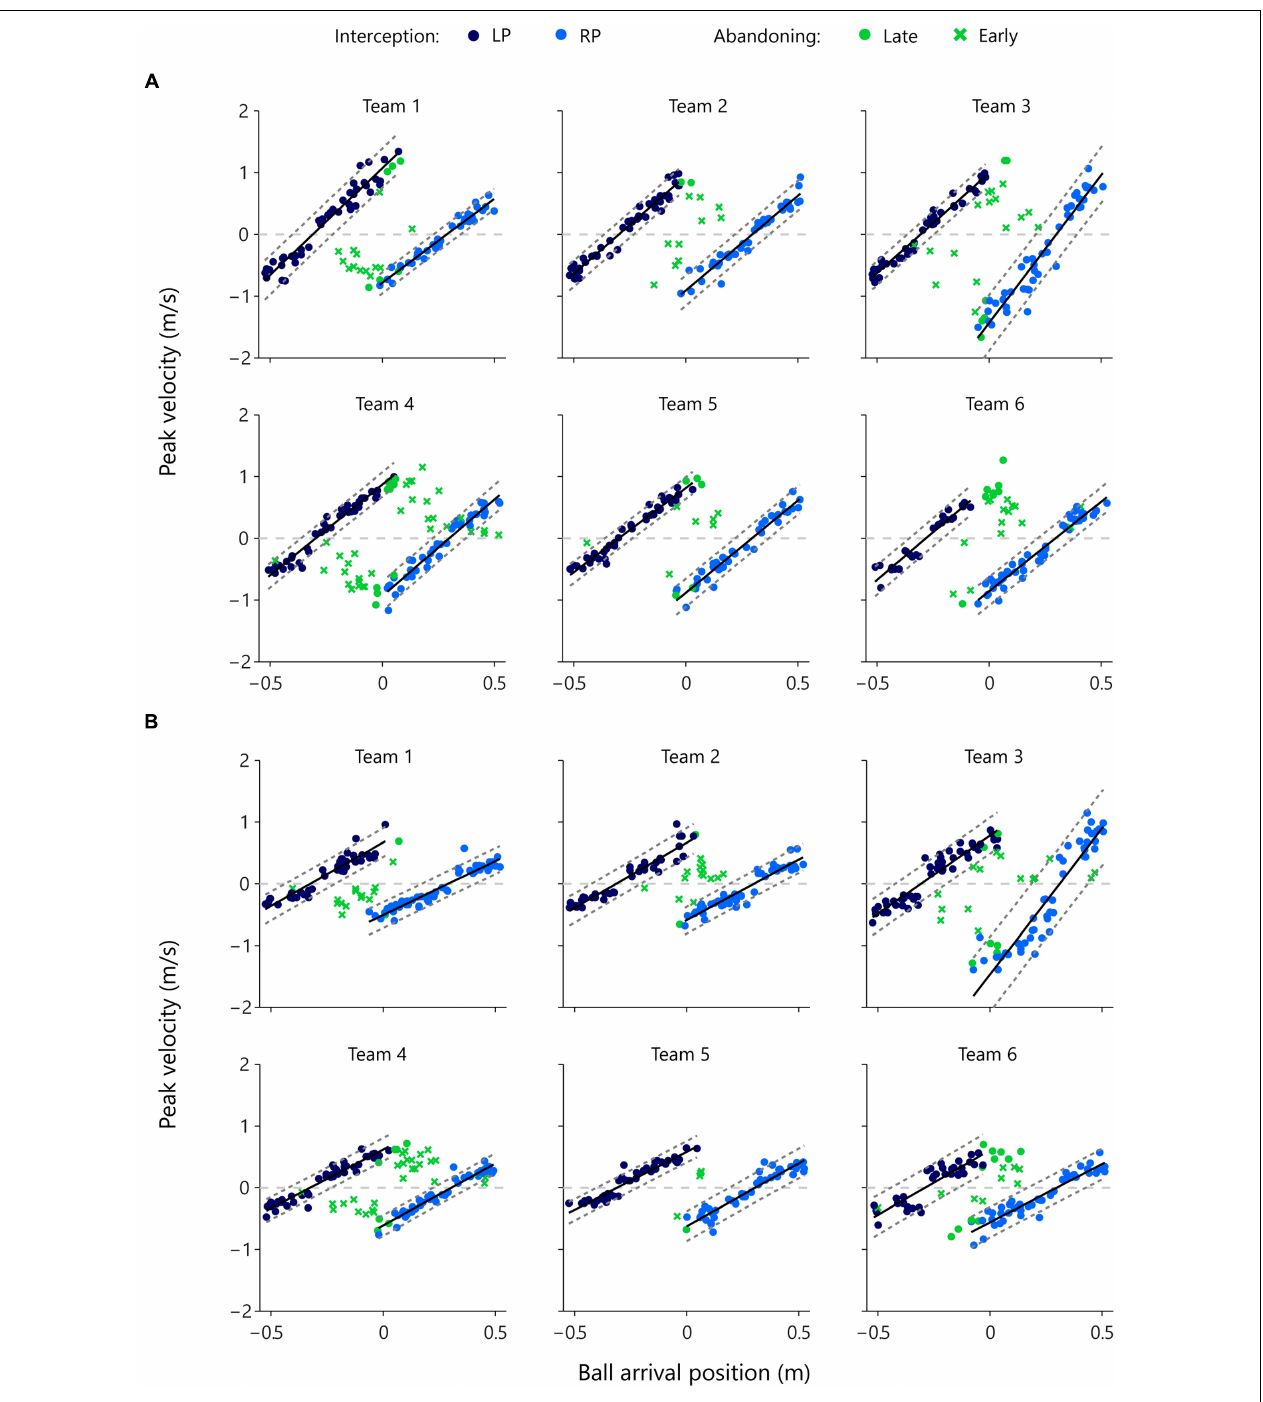
FIGURE 6 | Peak velocity of movement as a function of ball arrival position for both members of each team for each vertical ball speed separately. Dark blue dots indicate LP-interception trials and light blue dots indicate RP-interception trials. The solid black lines represent the associated regression lines of peak velocity onto ball arrival position and the dashed gray lines represent the ± 2 SD boundaries. Green symbols indicate trials in which interception was abandoned, with dots indicating that the peak velocity reached during that trial fell within the above-defined boundaries (late abandoning) and crosses indicating that the peak velocity reached during that trial fell outside the above-defined boundaries (early abandoning). The horizontal gray dashed lines in each panel, at peak velocity = 0 m/s, indicate the borders between negative (i.e., movements to the left) and positive (i.e., movements to the right) values of peak velocity. All green dots and crosses with positive peak velocity (i.e., all green points above the zero line) represent abandoned interception attempts of the LP. Likewise, all dots and crosses with negative peak velocity (i.e., all green points below the zero line) represent abandoned interception attempts of the RP. (A) High vertical ball speeds (0.64 m/s, 1-s trial duration) and (B) low vertical ball speeds (0.4 m/s, 1.6 s trial